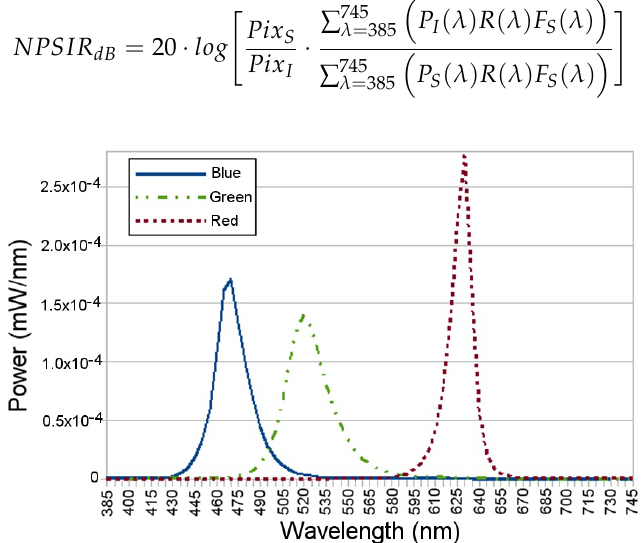
Figure 10. Optical Power emitted by the top left LED of the designed board turned ON in Blue, Green and Red respectively, data obtained using an optical spectrum analyzer.